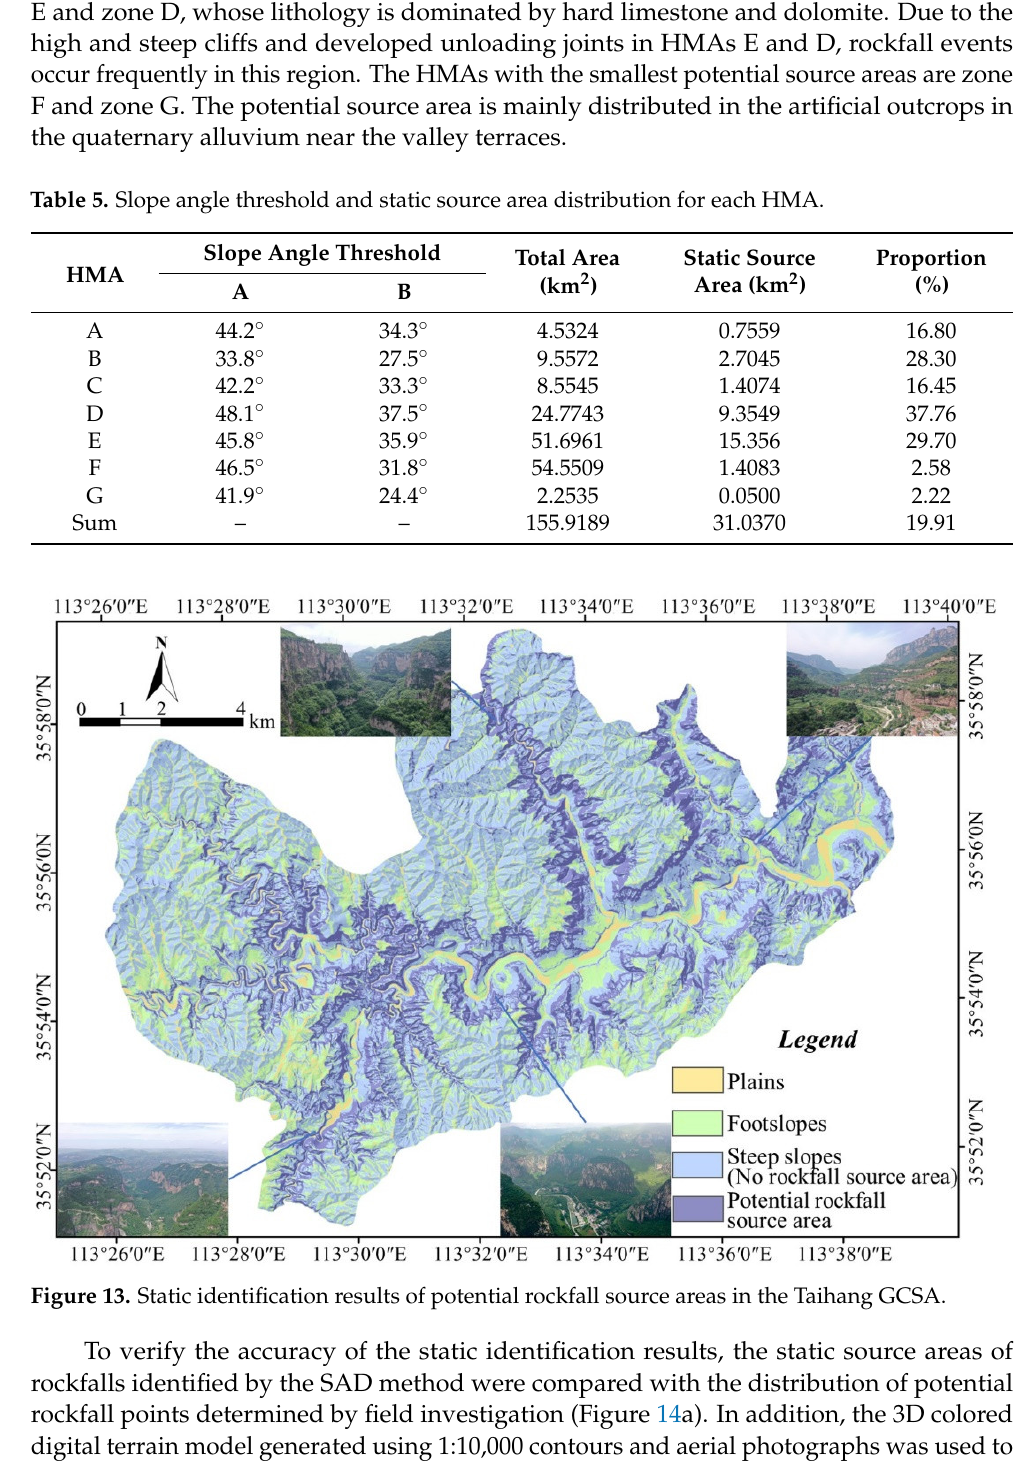
good inclusiveness, which was basically consistent with the actual field